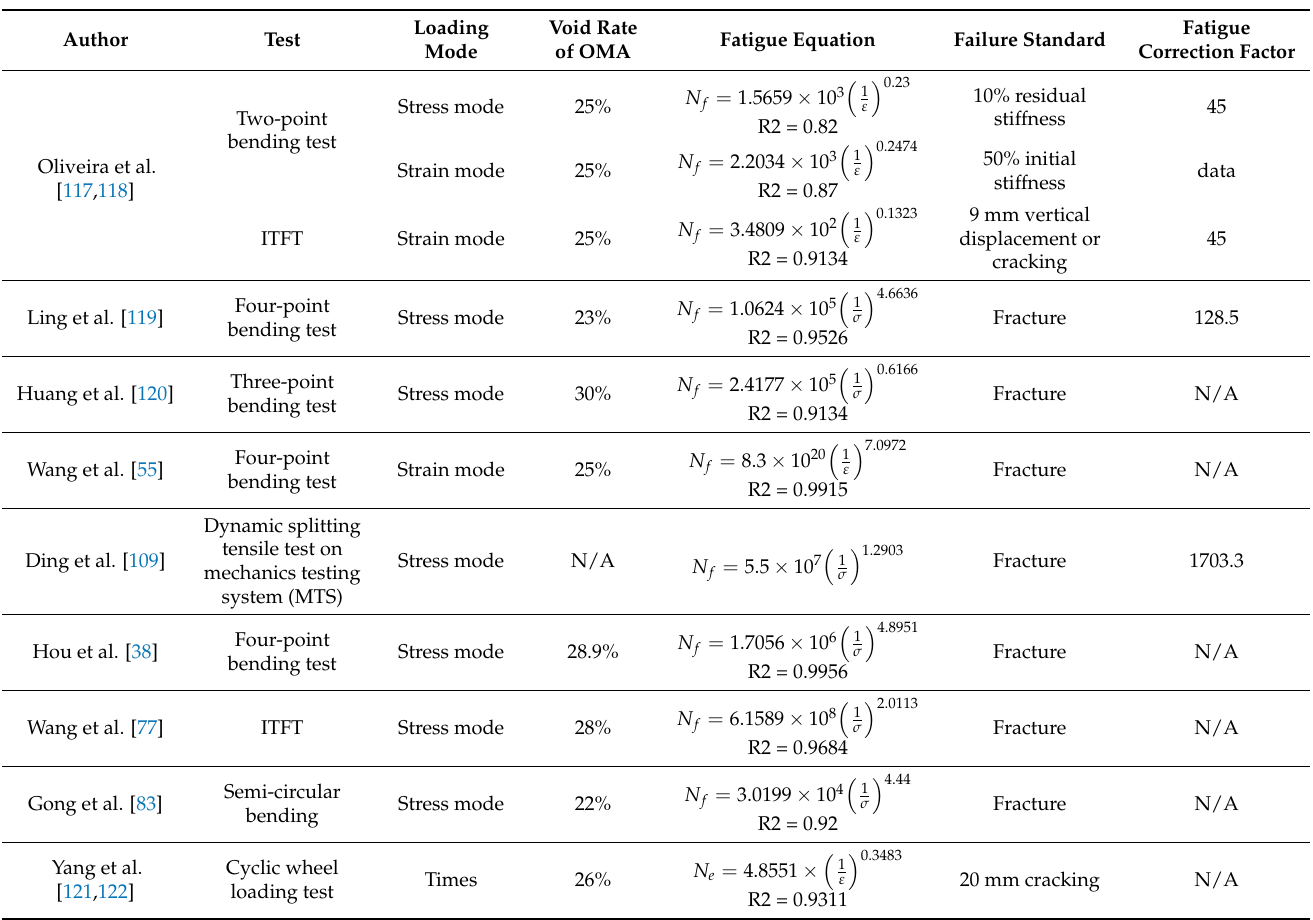
Table 11. Fatigue life behavior of